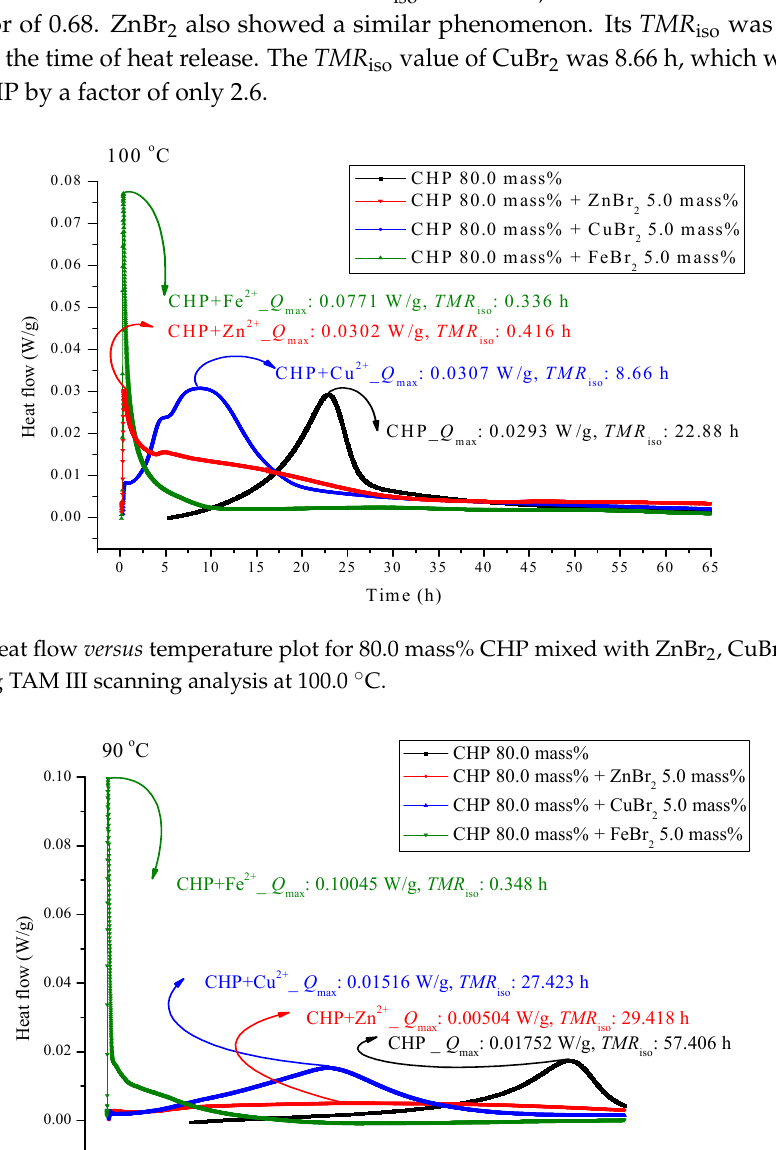
Figure 5. Heat flow versus temperature plot for 80.0 mass% CHP mixed with ZnBr 2 , CuBr 2 , or FeBr 2 , tested using TAM III scanning analysis at 90.0 °C.